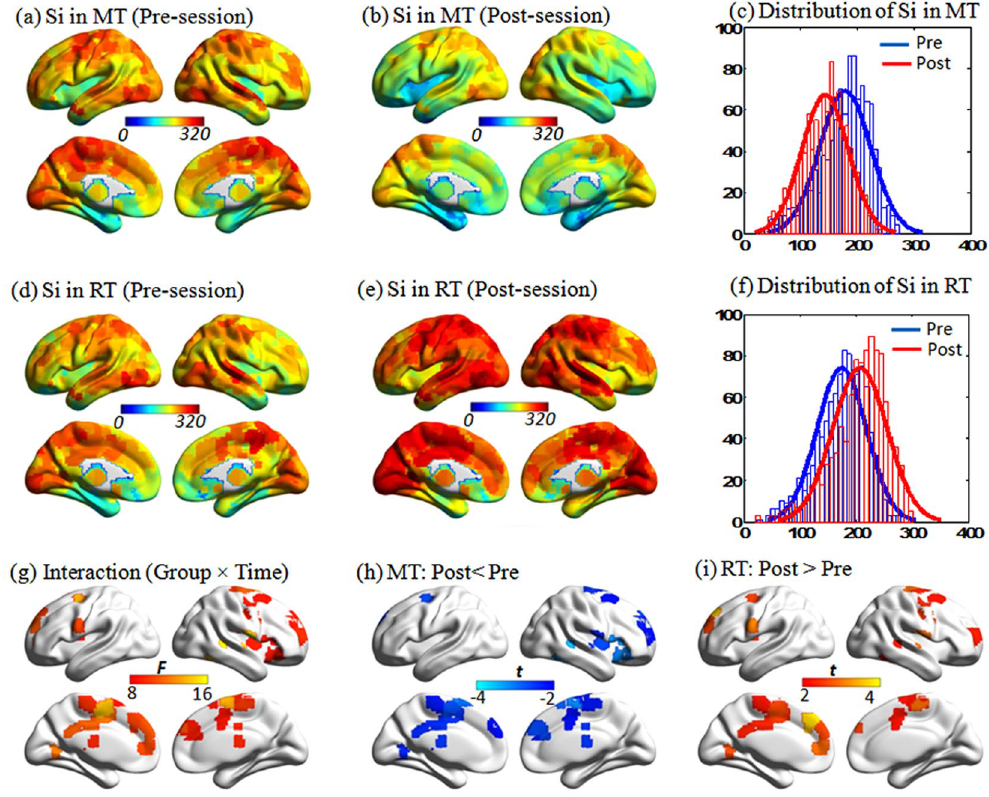
Figure 3. The effects of training on local nodal strength. ( a , b , d and e ) Local nodal strength distribution before and after training. ( c and f ) Local nodal strength distribution before and after training. ( g ) ANOVA analysis demonstrated the regions showing interaction effects between Timing and Group ( p < 0.005). ( h and i ) Showed the simple effect test for the mediation training (MT) and relaxation training (RT) group ( p < 0.05). Of note that nodes showed interaction effects were decreased after training in MT compared with before training, while RT group showed increased nodal strength after training. The results represented on the brain surface were mapped using the BrainNet viewer 52